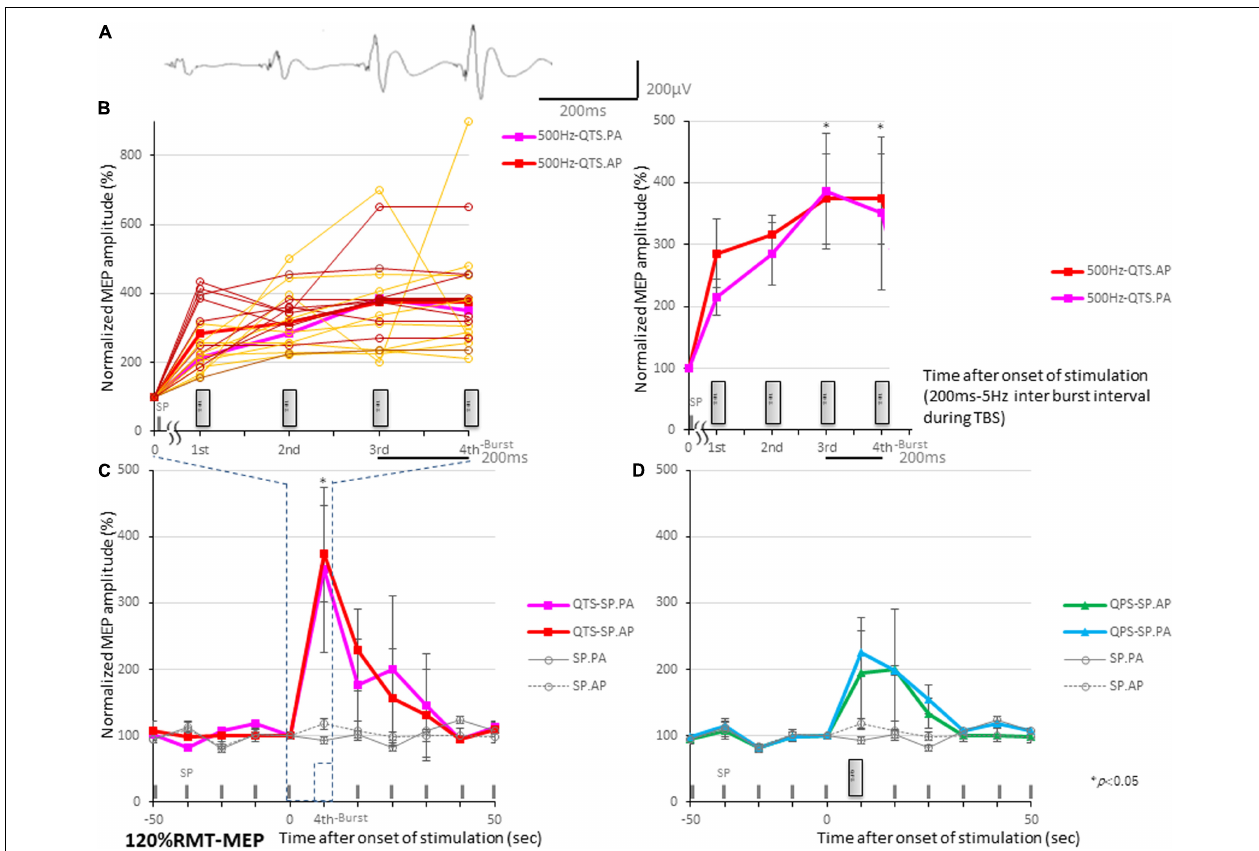
FIGURE 3 | Motor evoked potential (MEP) amplification during four 500-Hz high-frequency burst stimulations. (A) MEP amplification in quadripulse theta burst transcranial magnetic stimulation (QTS) during four-burst stimulations at theta rhythm in a healthy participant. Four independent MEPs were generated 20 ms after each burst onset [four pulses at 500 Hz (2-ms ISI), repeated at 5 Hz (200-ms interburst interval)]. MEP amplitudes linearly increased after each burst, finally reaching 350–370% of a single-pulse-MEP. (B) MEP amplification during 500-Hz QTS-PA and -AP, respectively. Four gray boxes designate each 500-Hz burst [individual trace overlay (PA: orange) and (AP: brown); left and averaged trace (PA: pink) and (AP: red); right]. Time-series data of MEP amplitudes expressed as percentage change from baseline attributable to TBS. Group data are presented as mean ± standard deviation. Analysis time and a time window of 800 ms were applied in QTS for MEP development acquisition after each burst during stimulation. (C) SP-MEP time course recorded at 10-s intervals before and after 500-Hz QTS (dark blue dashed box indicates time windows during QTS, corresponding to part B). (D) SP-MEP time course recorded at 10-s intervals before and after single 500-Hz QPS, PA, and AP-direction, respectively. SP-PA and AP-MEP control time courses are exhibited as gray-solid and dashed lines,